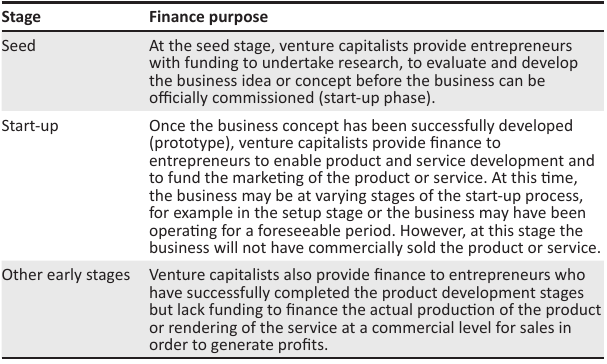
TABLE 1: Venture capital financing